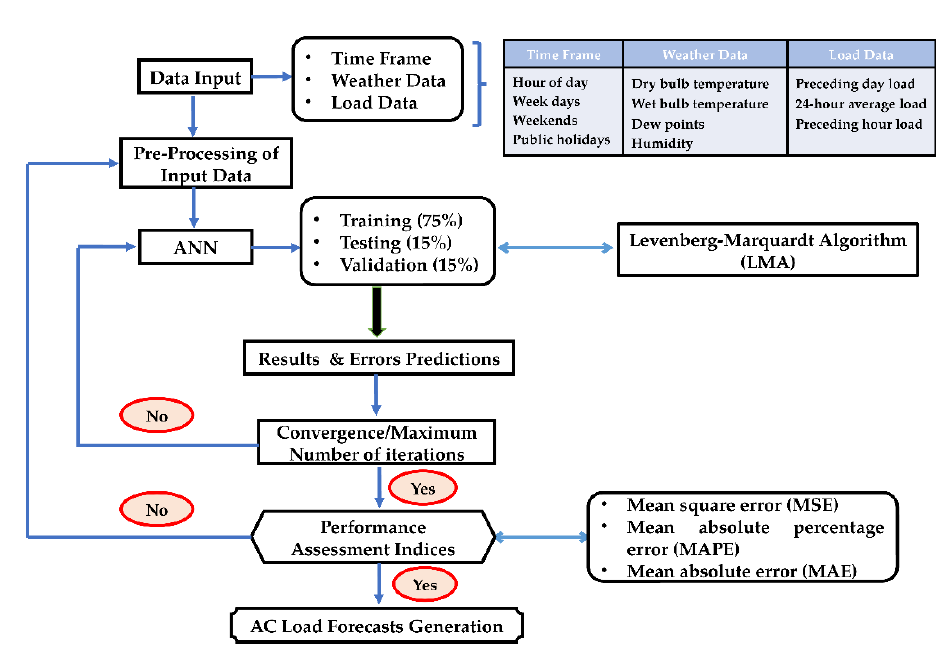
Figure 2. Flow chart for LMA-based ANN .